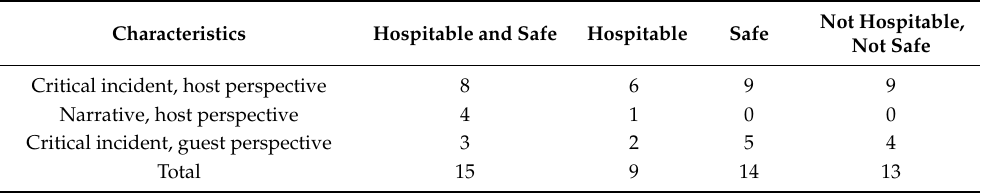
Table 1. Characterisation of the critical incidents and narratives.